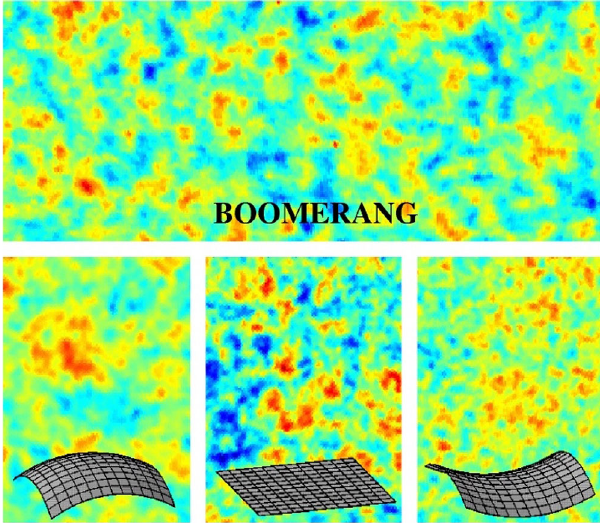
FIG. 1. Maps of the CMB will have a different characteristic angular scale depending on the curvature of space. In a spherical space (positive curvature, bottom left), the typical size of the hot and cold spots in the CMB will be larger than in a “ flat ” space (zero curvature, bottom middle) and will be smaller in a hyperbolic space (negative curvature, bottom right). By comparing models to data (top panel), the BOOMERANG team determined that the Universe as a whole is not curved. From the BOOMERANG Team.